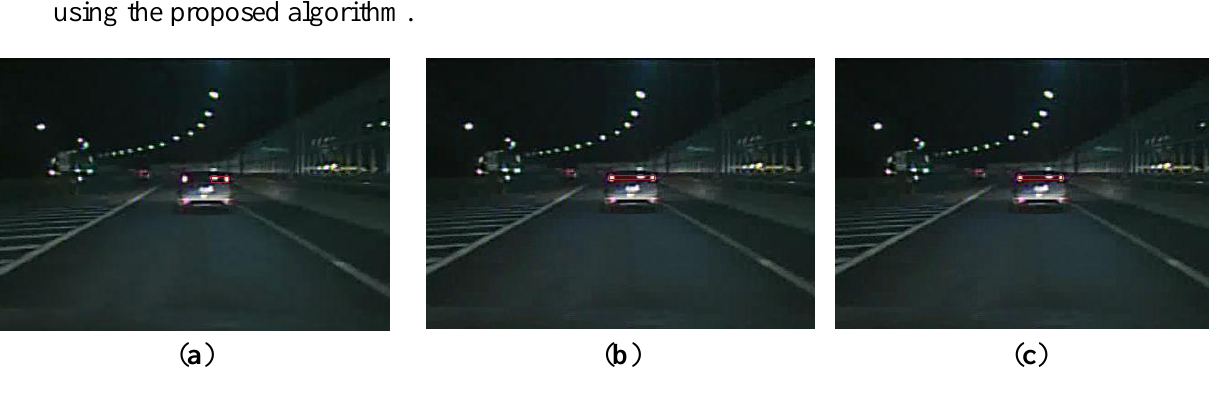
Figure 11. Comparison of vehicle detection results (case 2): ( a ) Result using the global rule-based algorithm; ( b ) Result using Kalman tracking-based global algorithm; ( c ) Result using the proposed